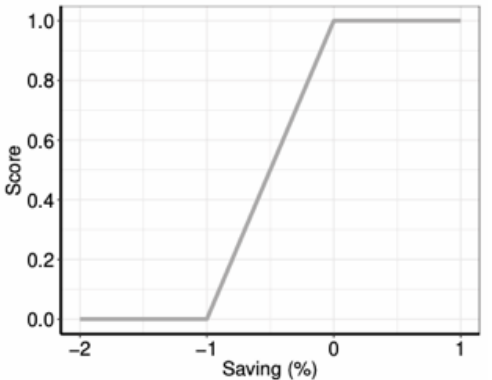
Figure A2. Utility function to calculate the motivation when abandoning practices for client and techno-solutionist households. This lineal function maps money savings relative to water bill to a score. Notice that abandoning more efficient practices produces negative variations. If variation of the cost is high, the utility to abandon the practice is null; in contrast, if abandoning the practice does not change the situation, it leads to the maximum score. This means that, with the same water bill, households prefer to use more water (which reflects a value, although not being explicitly modelled).